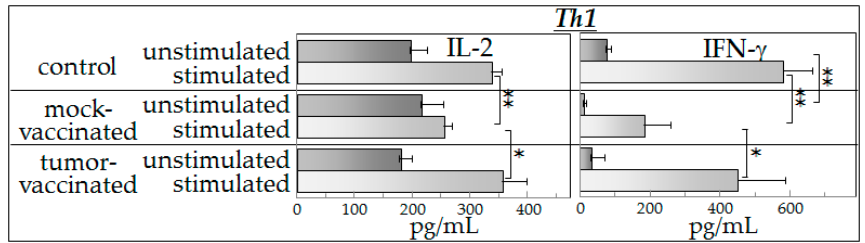
Figure 1. Vaccination of tumor-bearing mice restores production of increased levels of Th1 cytokines in the presence of tumor-derived products. Spleen cells from control mice and from vaccinated or mock-vaccinated glioma-bearing mice were cultured either with control medium (unstimulated) or with glioma-conditioned medium (stimulated). The levels of the Th1 cytokines, IL-2 and IFN- γ , released by the spleen cells into the culture supernatants were then measured. Data shown are means ± SEM, with spleen cell production of cytokines being measured in duplicate for each mouse individually. * p < 0.05, ** p < 0.01.